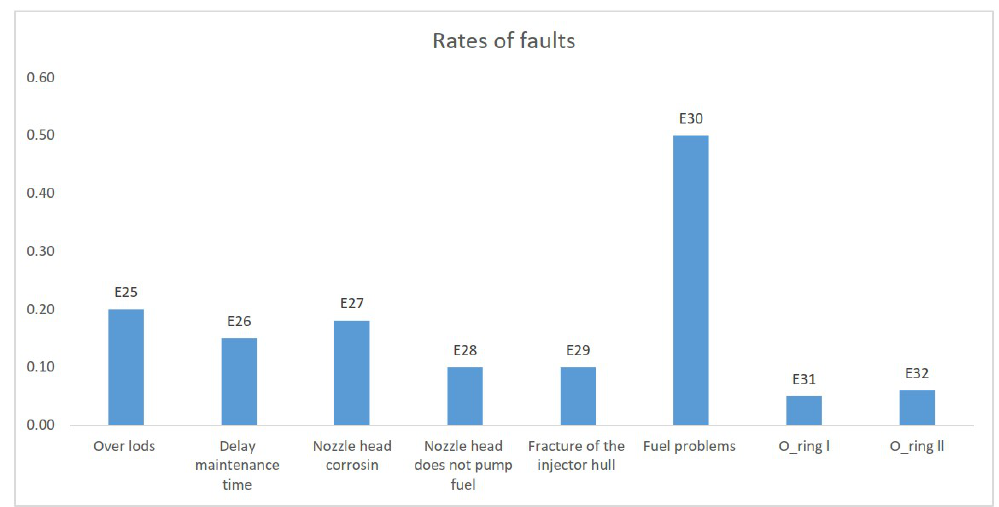
Fig. 6. The faults that occur to the diesel engine